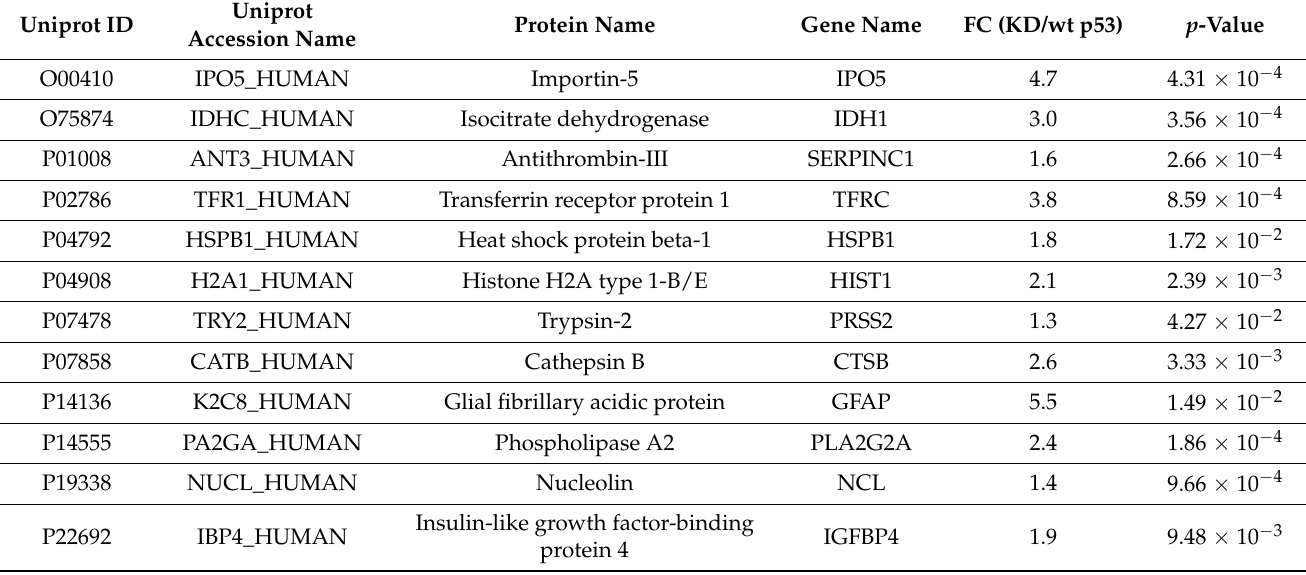
Table 1. Forty-seven modulated proteins in PDAC secretome of knock-down p53 Paca3 cells, as compared to wild-type p53 cells identified by SWATH-MS technology ( p < 0.05). Fold change (FC) represents the ratio between CM protein abundance of p53 knock-down (KD) and p53 wild-type PaCa3